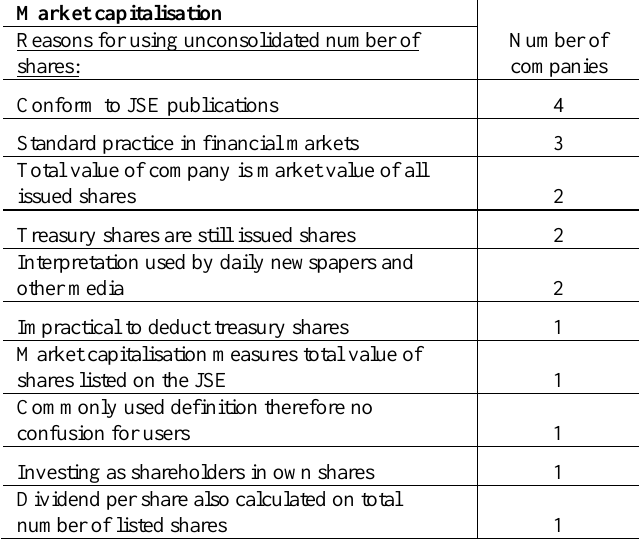
Table 2: Reasons for using specific number of